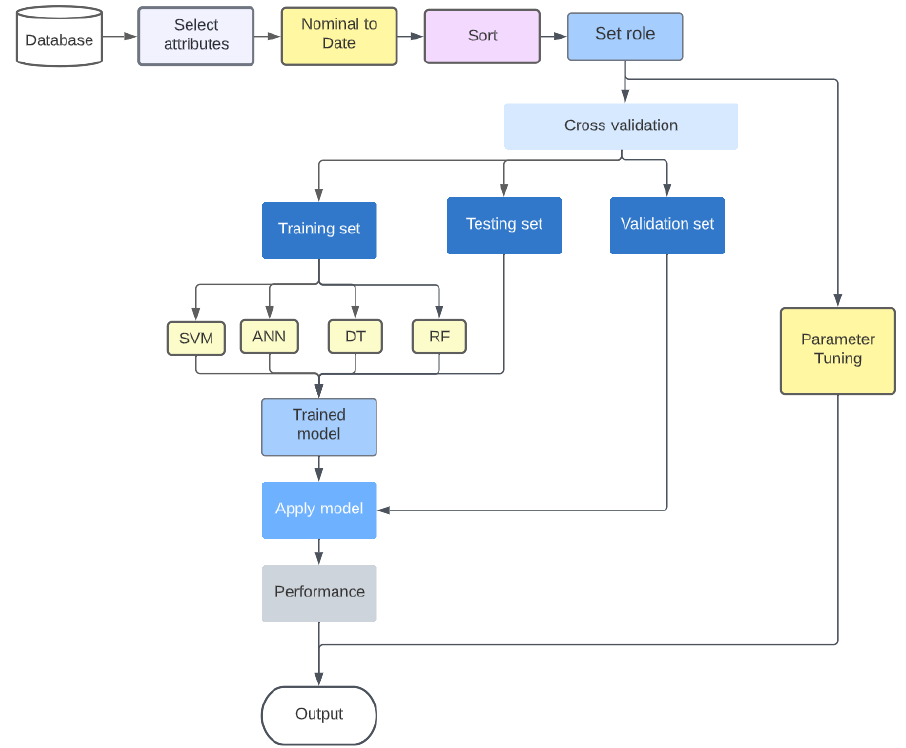
Figure 8. Flowchart of the process stream .